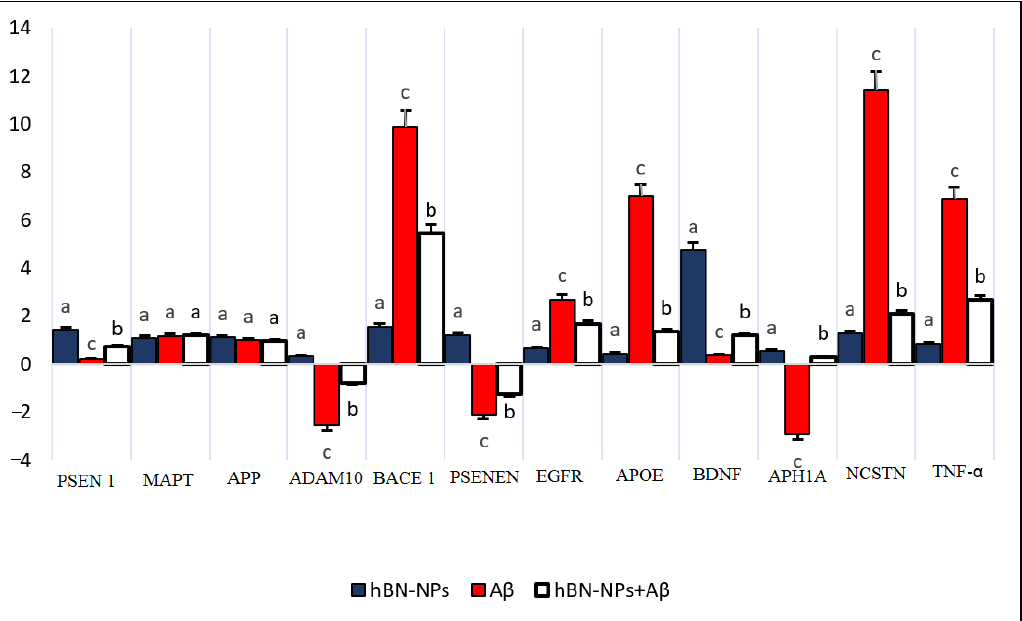
Figure 12. Effects of hBN-NPs and A β applications on expression of AD-related genes in differenti- ated SH-SY5Y cells. The mean ± SE values with different superscript letters on the bars for each gene are significantly different ( p < 0.05).